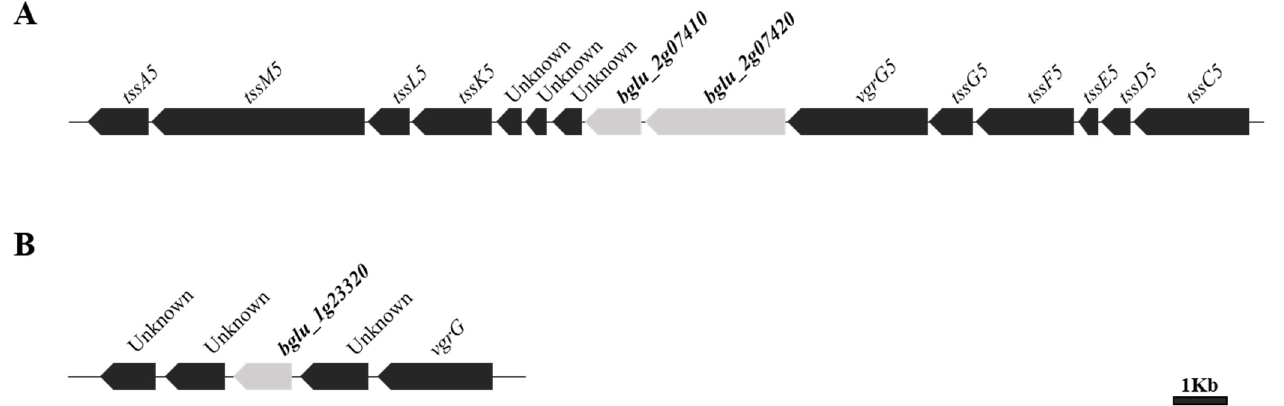
Figure 1. Genetic organization of T6SS group_5, containing bglu_2g07420 encoding the DUF2169- containing protein and bglu_2g07410 encoding pentapeptide repeats protein ( A ), and bglu_1g23320 encoding the DUF2169-containing protein ( B ) in Burkholderia glumae BGR1. The genes are indicated by the locus ID (e.g., bglu_2g07410 ) and are to scale. The genes marked in gray encode the DUF2169 domain-containing proteins and pentapeptide repeats